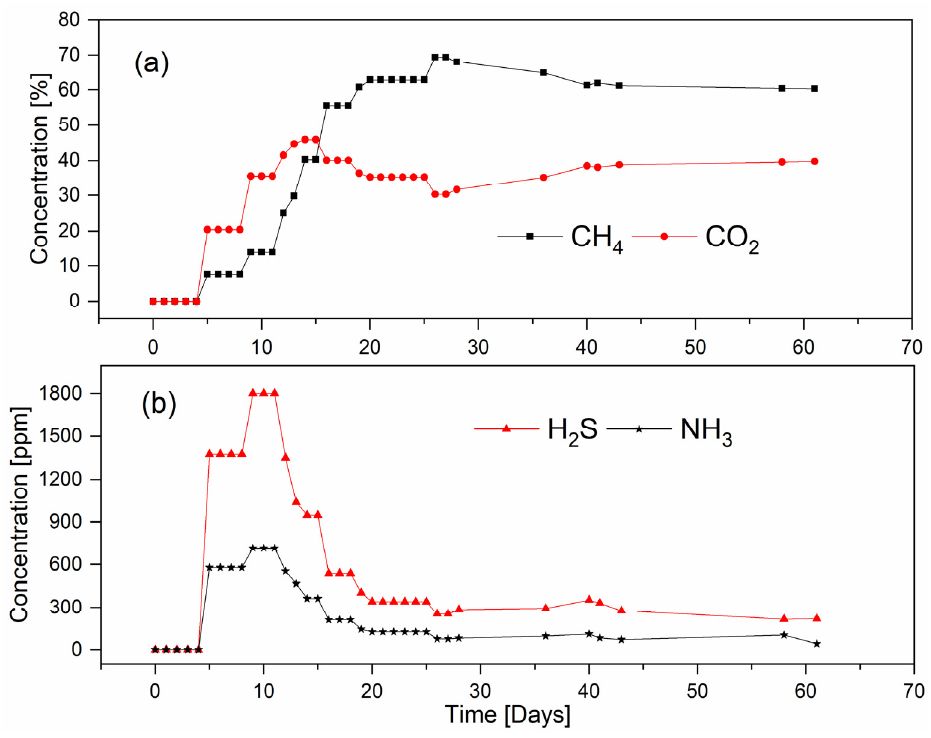
Figure 4. Variation of gas quality during digestion: ( a ) CH 4 and CO 2 concentrations; ( b ) H 2 S and NH 3 concentrations.